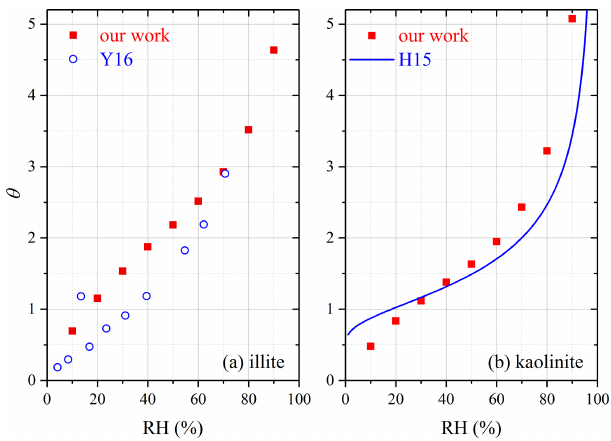
Figure 7. Comparison of water adsorption on montmorillonite ex- amined in different studies: (a) surface coverages of adsorbed wa- ter ( θ ); (b) the mass ratio of adsorbed water to the dry min- eral ( m w /m 0 ). F05, Frinak et al. (2005); S07, Schuttlefield et al. (2007b); H11, Hatch et al. (2011); H15, Hung et al. (2015); Y16, Ye¸silba¸s and Boily